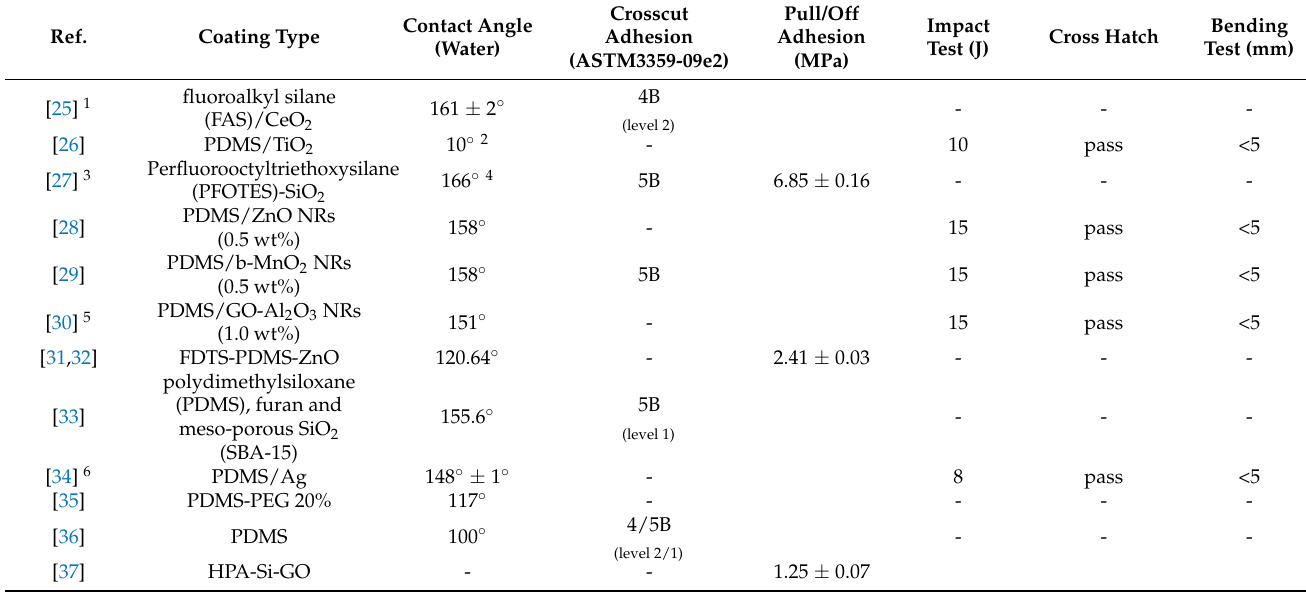
Table 1. Contact angle and mechanical characterization of silane-based coatings.